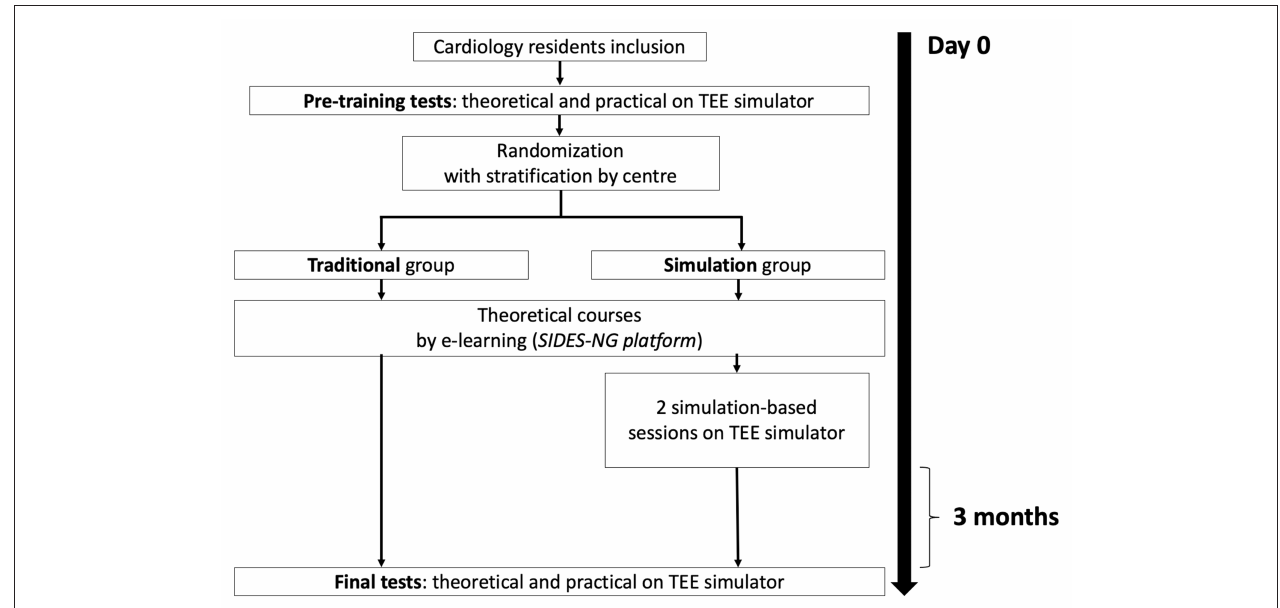
FIGURE 1 | Flowchart of the study with schedule for training sessions and examinations in the two